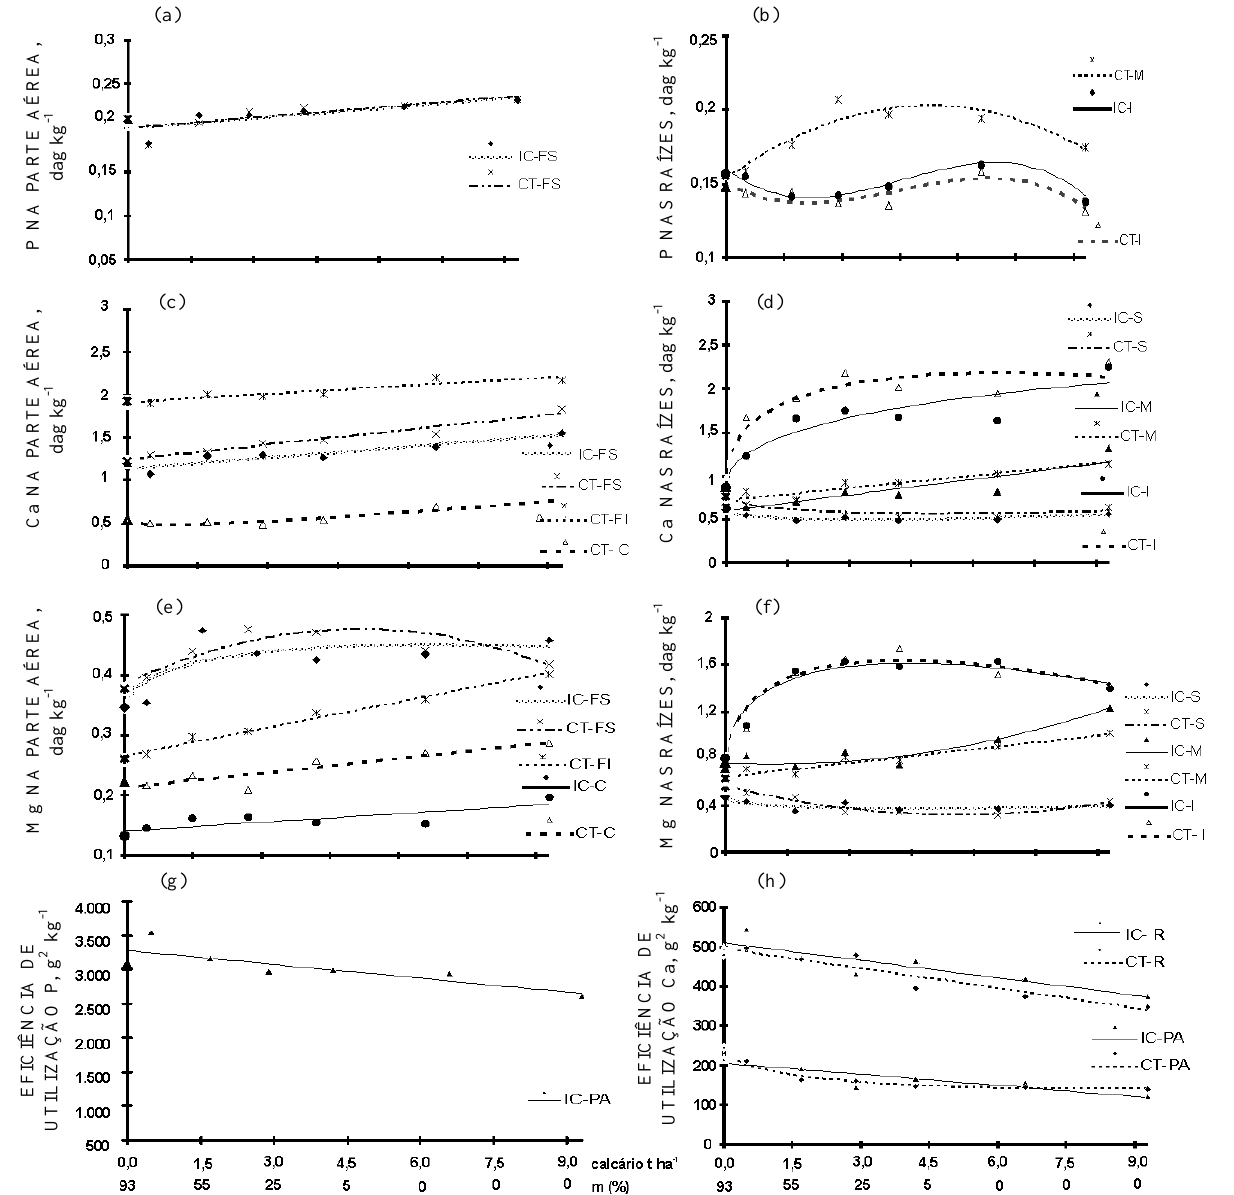
Figura 2. Teores na parte aérea e nas raízes de P (a, b), de Ca (c, d) e de Mg (e, f) e eficiência de utilização de